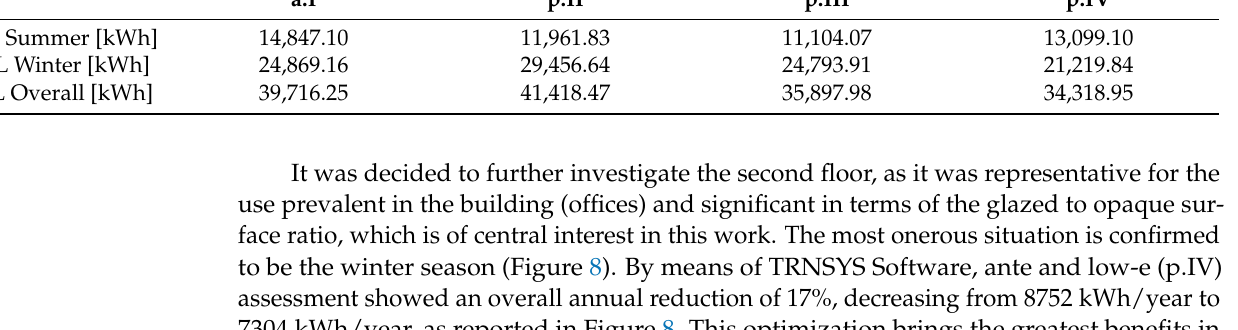
Table 5. Summer, winter and overall annual energy